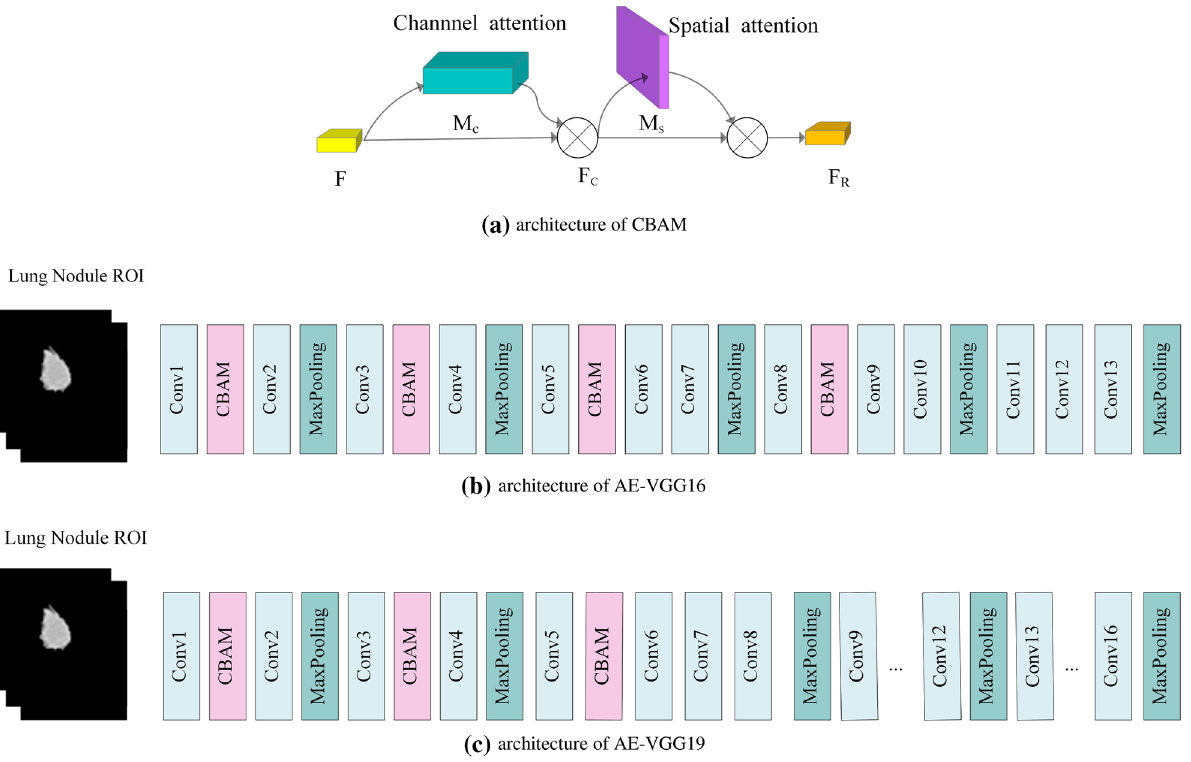
Figure 4. Architecture of attention-embedded